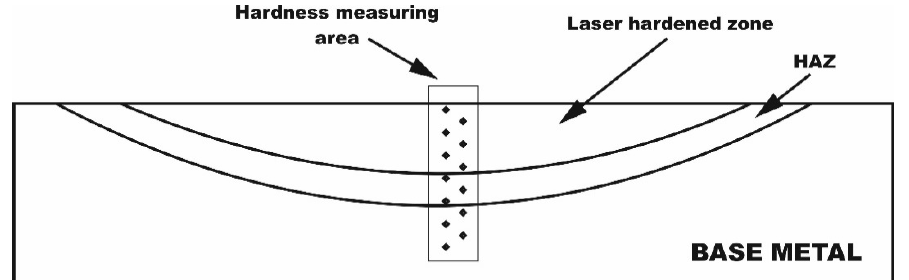
Figure 2. The scheme of hardness measurements.